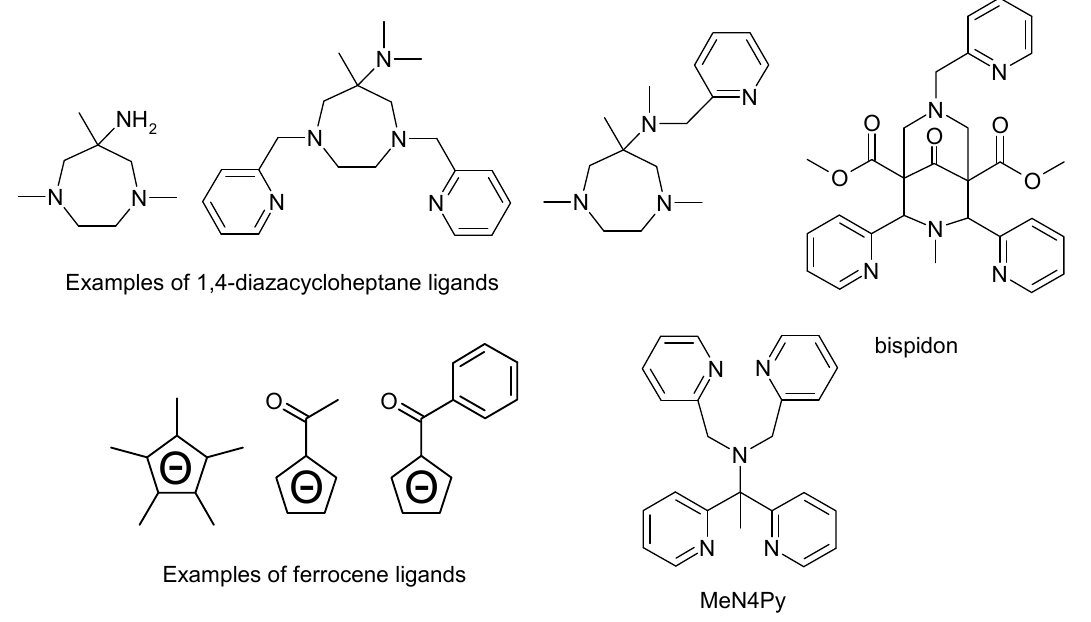
Figure 4. Ligands exhiting paint drying activity as Fe-ligand complexes. Examples of 1,4-diazacycloheptane based ligands depicted: 6-amino-1,4,6-trimethyl-1,4-diazacycloheptane, 6-dimethylamino-1,4-bis(pyridine-2-ylmethyl)-6-methyl-1,4-diazacycloheptane, 1,4,6-trimethyl-6{ N -(pyridin-2-ylmethyl)- N -methylamino}-1,4-diazacycloheptane, bispidon = dimethyl 3-methyl-9-oxo-2,4-di(pyridin-2-yl)-7-(pyridin-2-ylmethyl)-3,7-diazabicyclo[3.3.1]nonane-1,5-dicarboxylate, examples of ferrocene ligands depicted: ferrocene, acylferrocene, benzeneacylferrocene, and MeN4Py = N , N -bis(pyridin-2-ylmethyl)-1,1-bis(pyridine-2-yl)-1-amino-ethane.